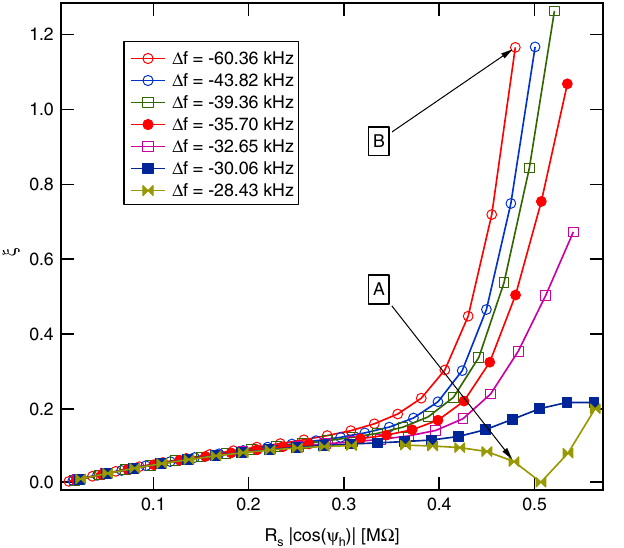
FIG. 4. The rms bunch length as a function of harmonic cavity shunt impedance for various values of harmonic cavity detuning. cos ψ The points identified by A and B correspond to the cases s j h j displayed in the plots of Fig. 1 and Fig. 2, respectively.